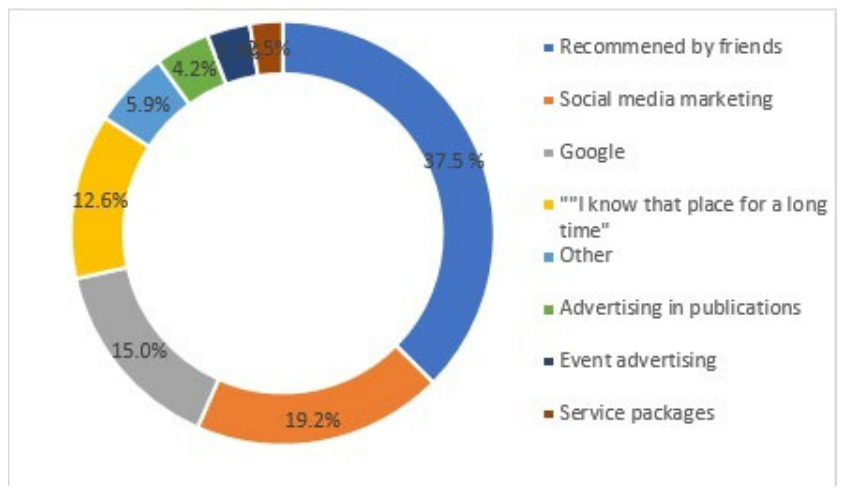
Figure 2. Distribution of primary communication channels among